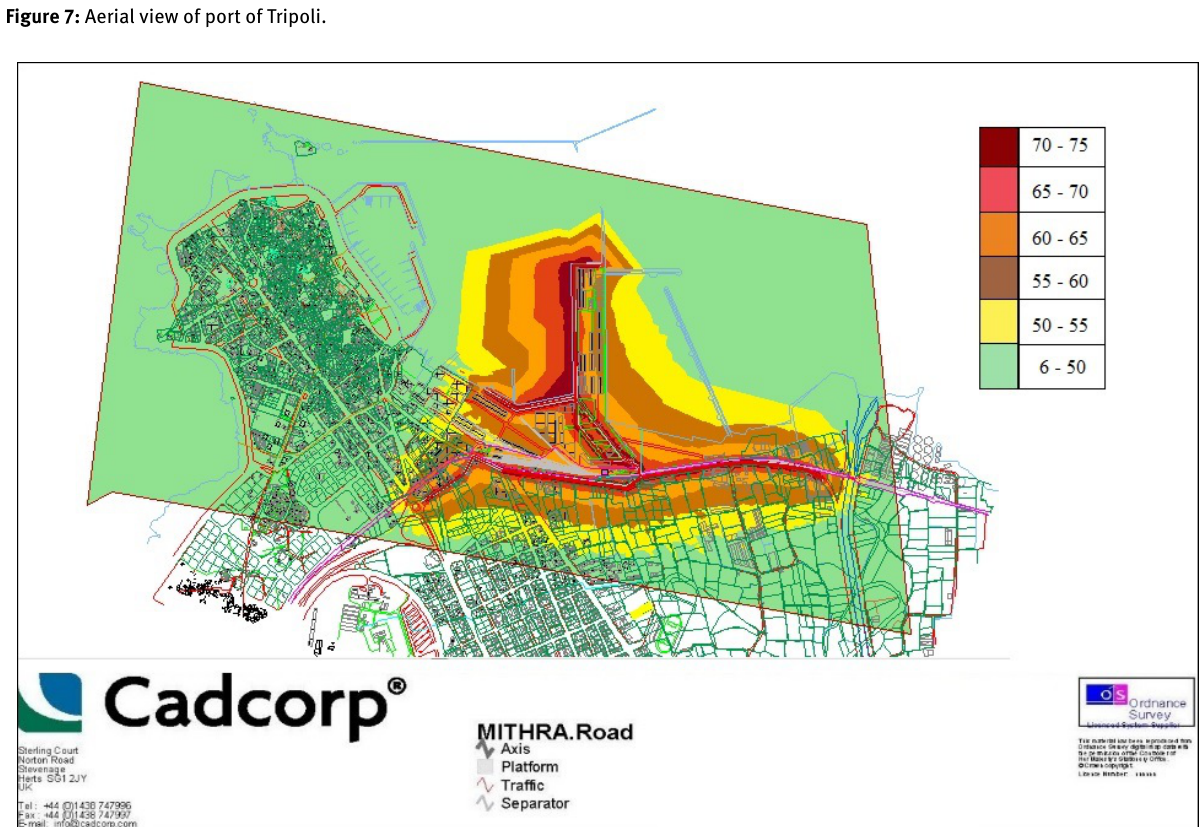
Figure 7: Aerial view of port of Tripoli.